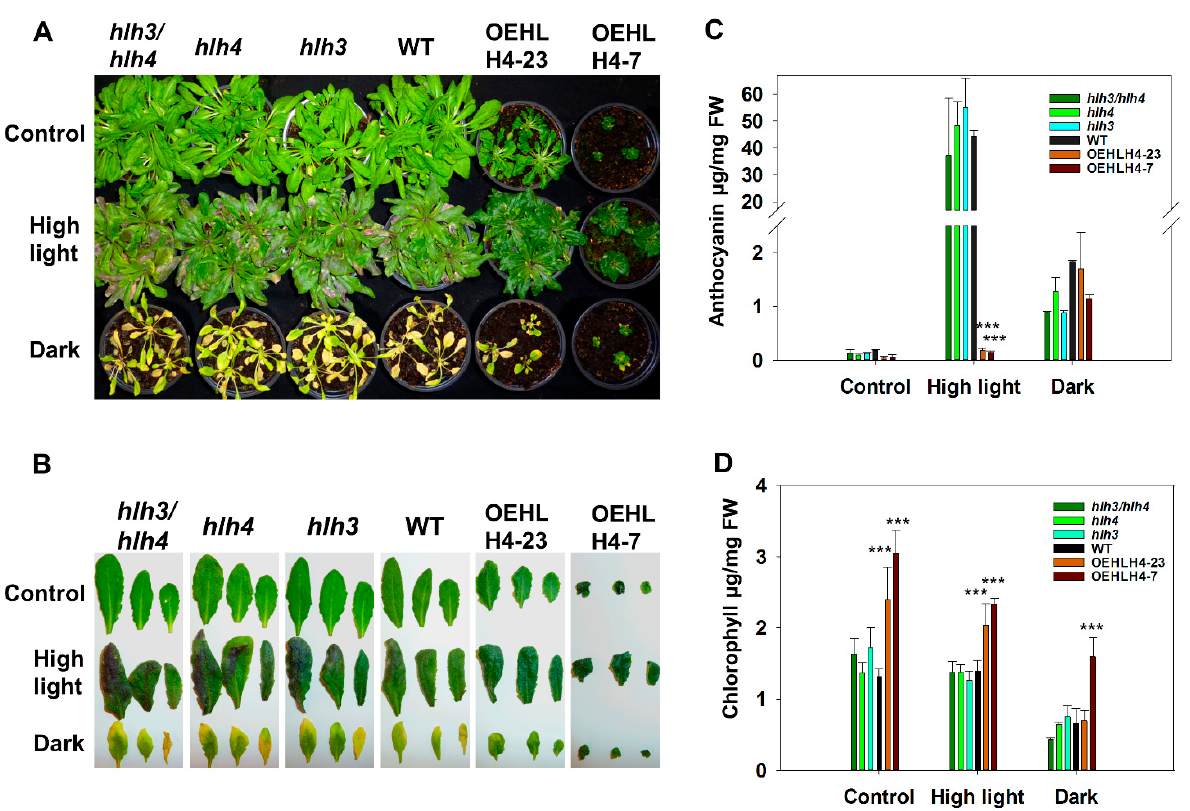
Figure 4. Overexpression of HLH4 prevents anthocyanin accumulation. ( A ) Four-week-old HLH4 overexpression, hlh4 , hlh3 , hlh3hlh4 , and wild type A. thaliana plants were treated with darkness or high light stress for seven days. ( B ) Leaf samples from plants as shown in ( A ). ( C ) Chlorophyll contents of plants as shown in ( A ). ( D ) Anthocyanin contents of plants as shown in ( A ). Data represent mean ± SD of three biological replicates with three technical replications ( n = 9). Asterisks indicate significant differences (*** p < 0.001).